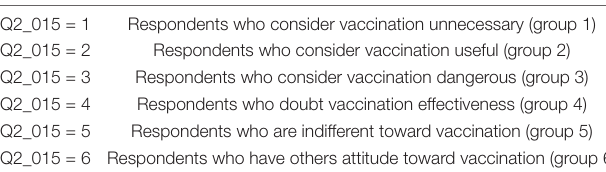
TABLE 4 | Respondents’ groups as divided by the factor of their attitudes toward